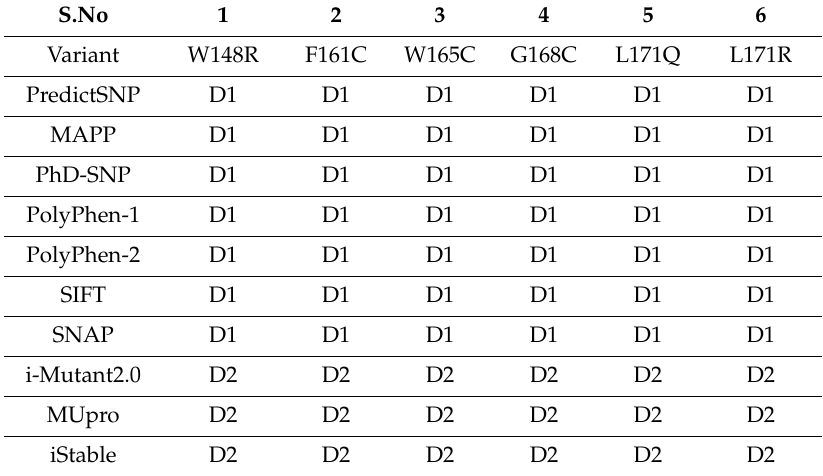
Table 1. Selected variants that exhibited deleterious and decreased from all prediction